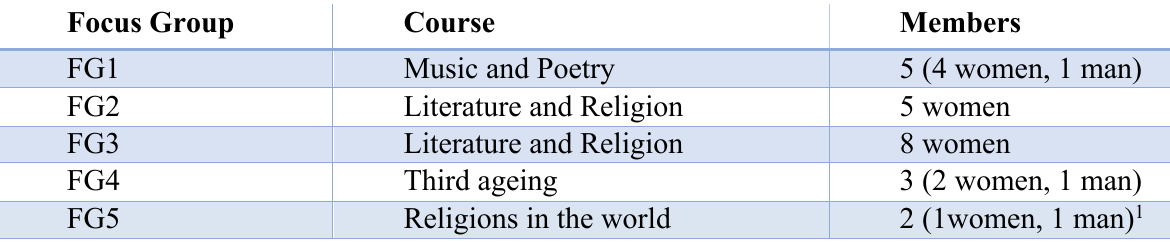
Table 1. Number of focus groups and